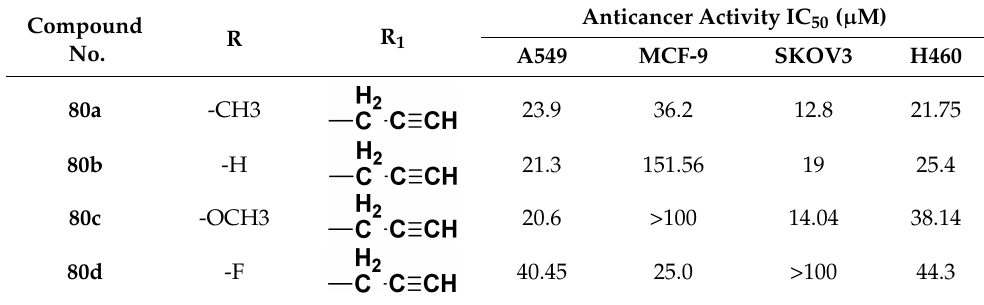
Figure 77. Structure of curcumin-quinolone derivatives ( 80 ). Table 66. In vitro cytotoxic activities of curcumin-quinolone hybrid compounds 80 ( a – d ).